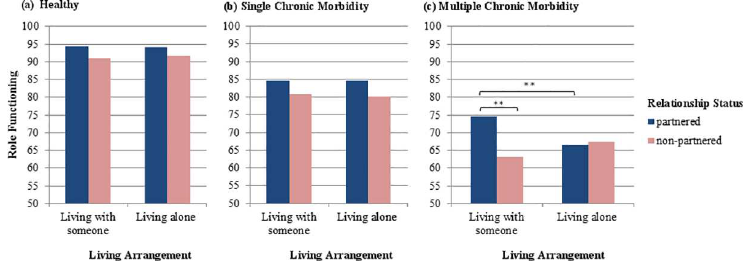
Fig 2. Interaction-effect of relationship status and living arrangement for (a) healthy individuals, individuals with (b) single and (c) multiple chronic morbidity. Note. The y-axes displayestimated mean values of role functioning adjusted for genderand age; ** p <